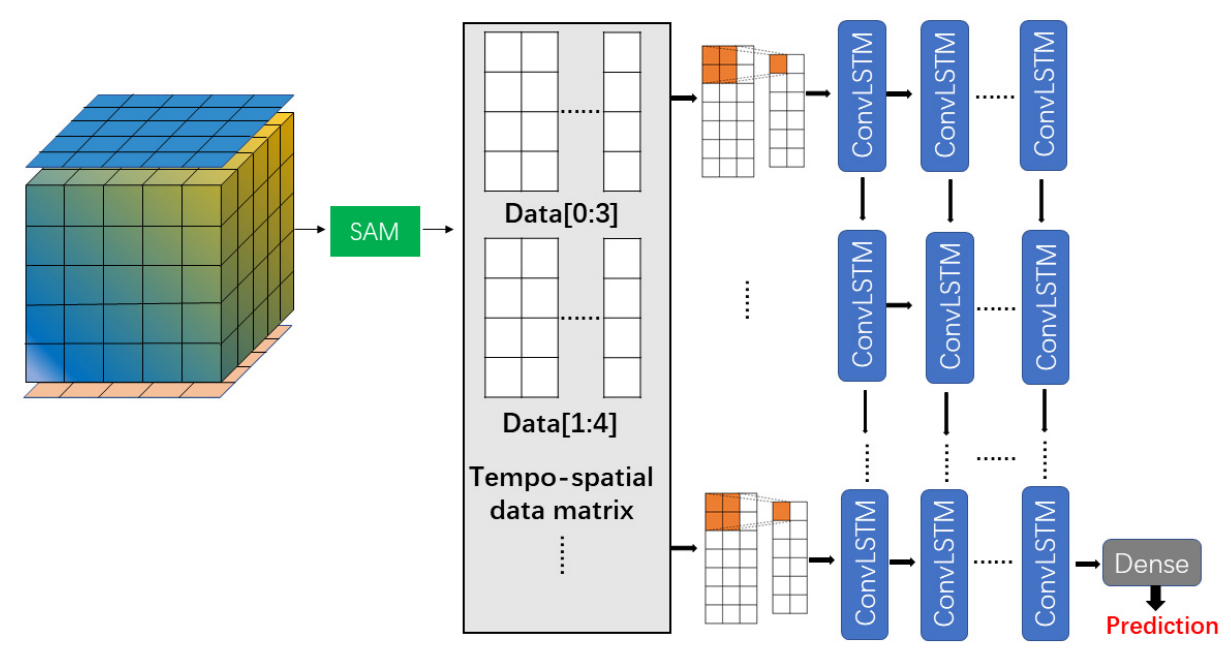
Figure 4. Overview of the proposed TITP-Net. The model input is the combined spatio-temporal environmental field. This diagram is a TITP-Net visualization based on the input data with timestep of 4.